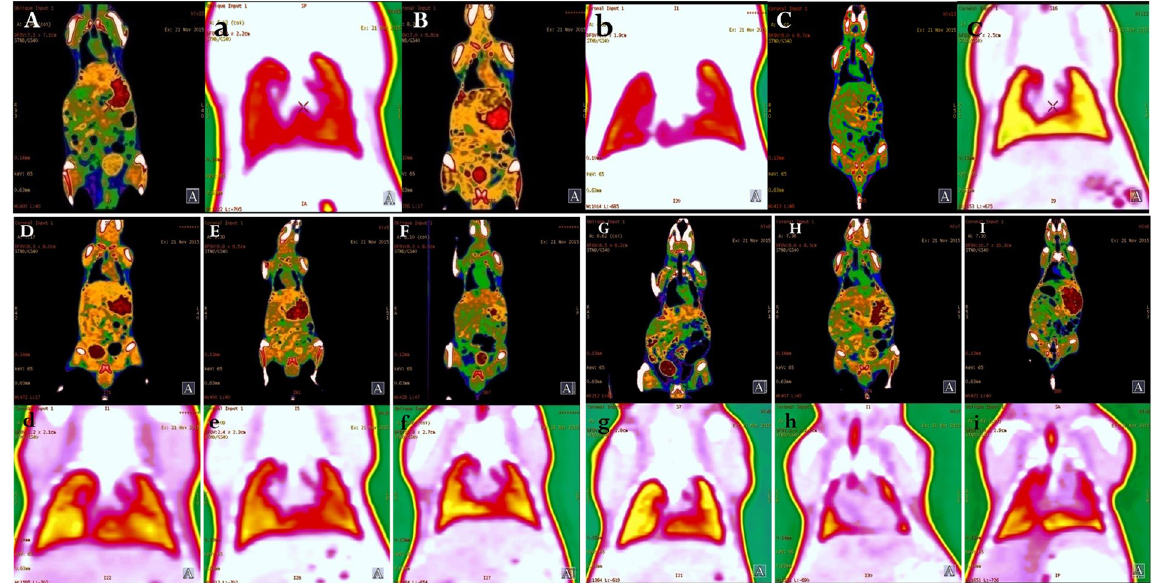
Figure 2. The CT imaging of Ag/oMWCNTs in mice with affection by different dosage of DOPC/or TD ( A , B , C is the whole CT imaging of mice after exposure saline solution, single Ag nanoparticles, Ag/ oMWCNTs, respectively; (a,b,c) is the lung CT imaging for control, single Ag nanoparticles and Ag/oMWCNTs, respectively; ( D,E,F ) is the whole CT imaging and (d,e,f) is the lung CT imaging of mice after exposure 6.2, 12.4 and 18.6 mg/kg.bw TD to oMWCNTs-model mice, respectively; ( G,H,I ) is the whole CT imaging and (g,h,i) is the lung CT imaging of mice after exposure 6.2, 12.4 and 18.6 mg/kg.bw DOPC to oMWCNTs-model mice,